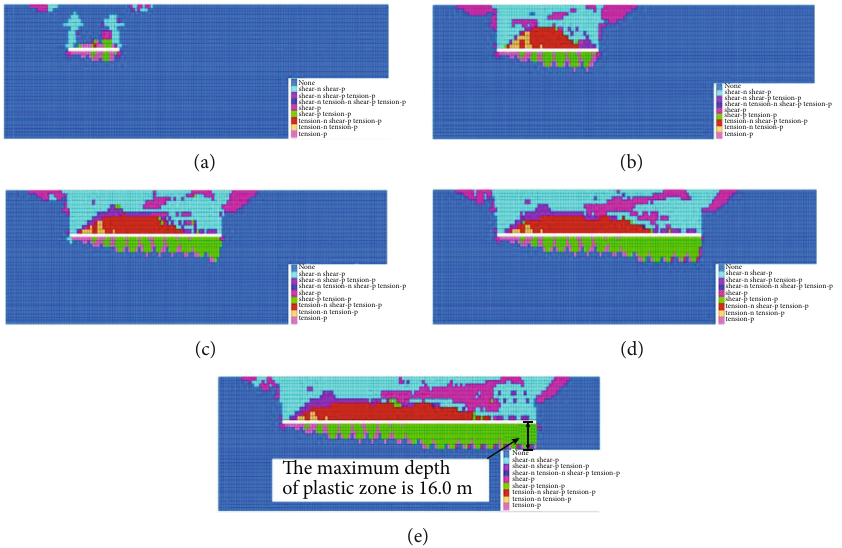
Figure 7: Distribution of plastic zone along the strike in the middle fl oor of the working face.